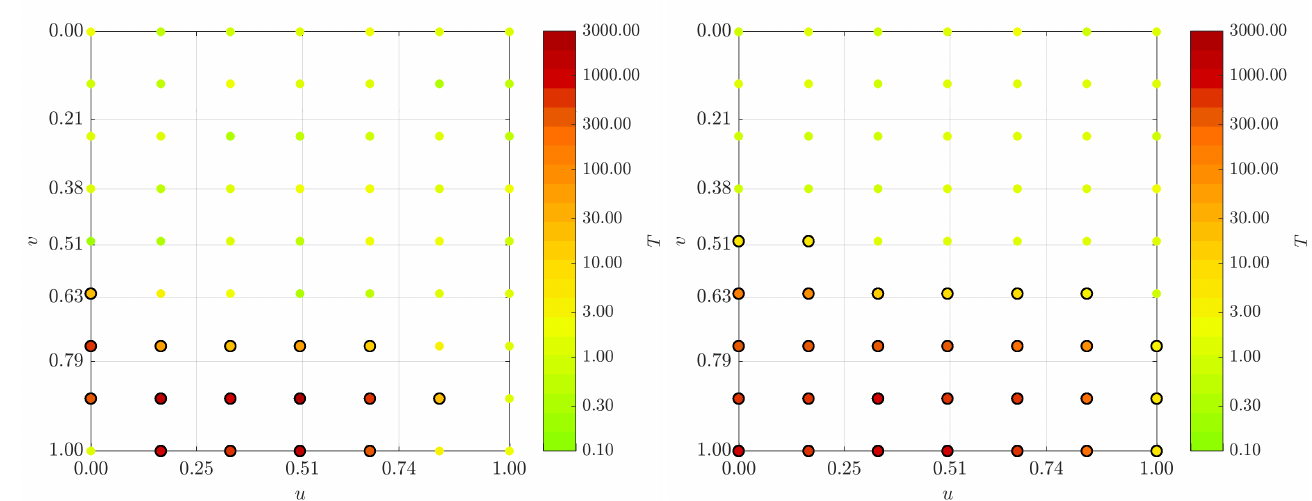
Figure 11. Test values T of the localisation procedure for data set V18. For the circled points, the null hypothesis has to be rejected and, thus, these points are assumed to lie in the distorted region. Left: a = 0, right: a = 1.